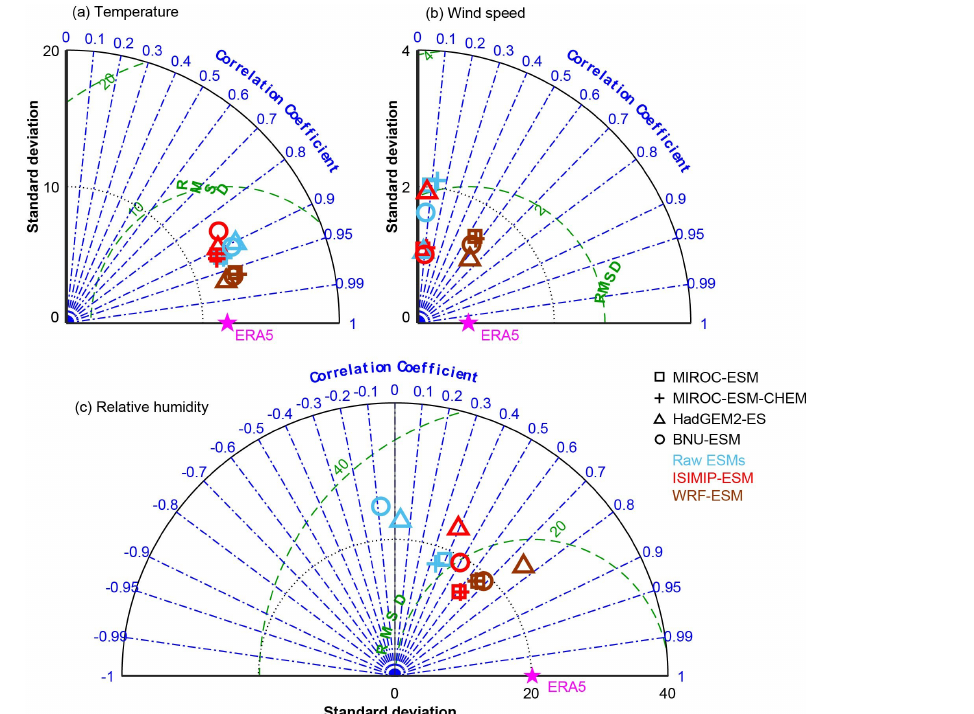
Figure 5. Taylor diagram for daily temperature (a) , wind speed (b) and relative humidity (c) of four ESMs using two downscaling methods, i.e. ISIMIP (red) and WRF (brown) compared to ERA5 data during 1980–1989 in Beijing. The blue symbols are the data from raw ESMs. The skill of downscaling methods is reflected by the distance from each symbol to the point labelled “ERA5”, the ERA5 reanalysis data. The blue lines are the correlation coefficient which represents the similarity between each downscaling data and reanalysis data. The green contours are root mean standard deviation (RMSD), and black contours are standard